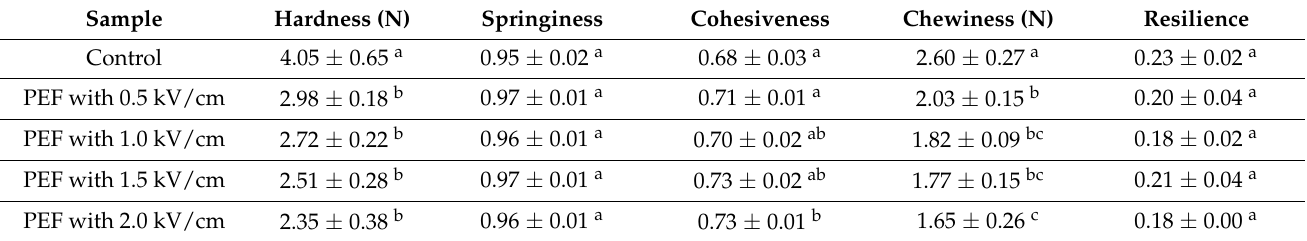
Table 1. Texture profile analysis (TPA) of PEF-treated beef at different field strengths.